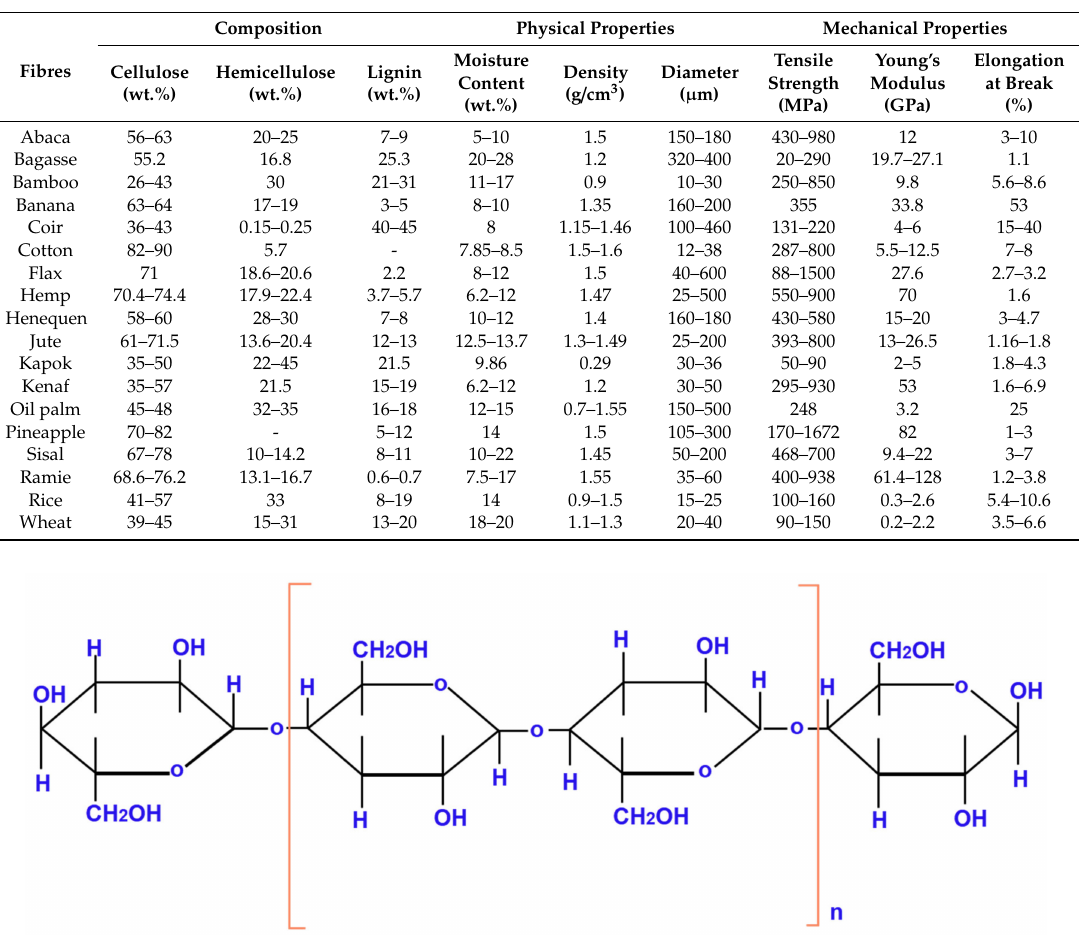
flame retardant (suppressed by the addition of the nature-based polymers). Some of the key properties of the polymer matrices are illustrated in Table